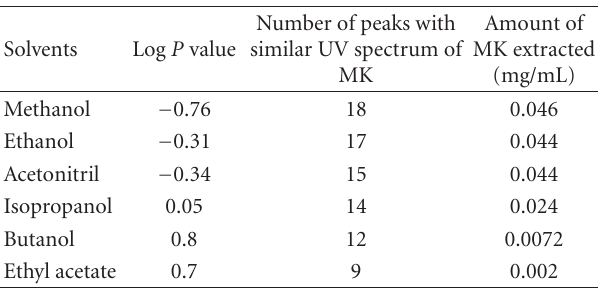
Table 1: The e ffi ciency of di ff erent solvents on quantity of monacolin K and quality of monacolins.